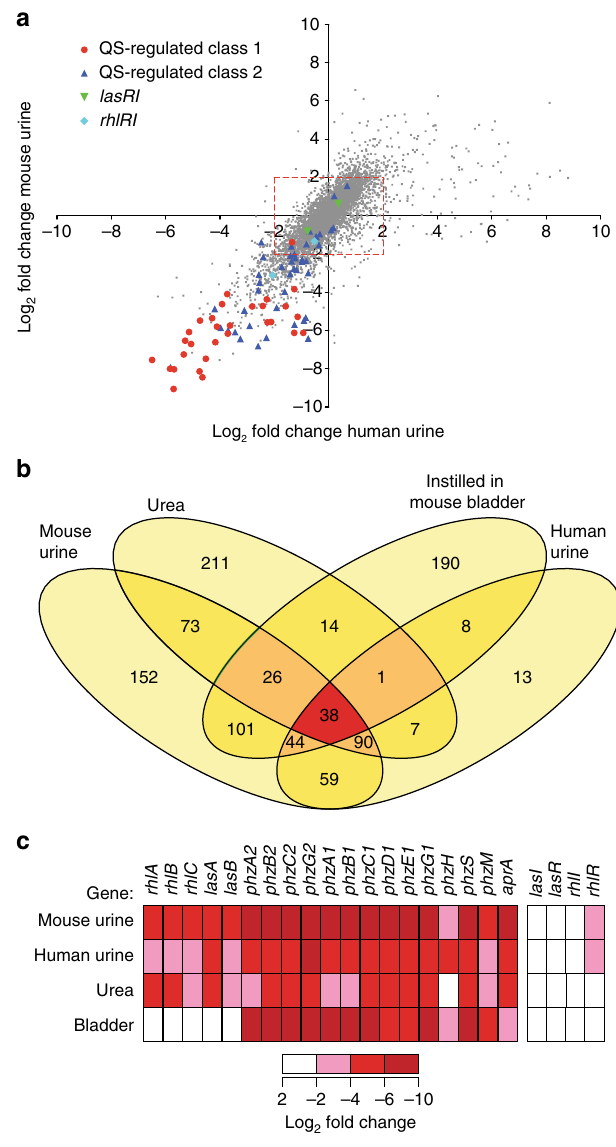
Fig. 1 Urine and urea suppress the expression of quorum-regulated genes. a Comparisons of log 2 fold changes in gene expression between LB vs mouse and human urine. Genes with less than four-fold change are within the box indicated by the red dashed line. The quorum-sensing-regulated genes were de fi ned as those genes that had 20-fold decreased in Wagner et al. 25 and 40- fold decreased in Schuster et al. 26 in strains lacking lasI rhlI and lasR rhlR , respectively. Red circles indicate quorum-sensing-regulated genes that were identi fi ed in both studies (class 1), dark blue triangles indicate quorum- sensing-regulated genes that were identi fi ed in one of the two studies (class 2), green inverted triangles indicate lasR and lasI genes, and light blue diamonds indicate rhlR and rhlI genes. b Venn diagrams comparing the number of P. aeruginosa genes with four-fold reduction in expression when grown in mouse urine, human urine, media containing urea, and instilled in the mouse bladder as compared to bacteria grown in LB. c Heat map showing log 2 fold gene expression changes of quorum-sensing-regulated genes in the presence of indicated urine, urea, and instillation into a mouse